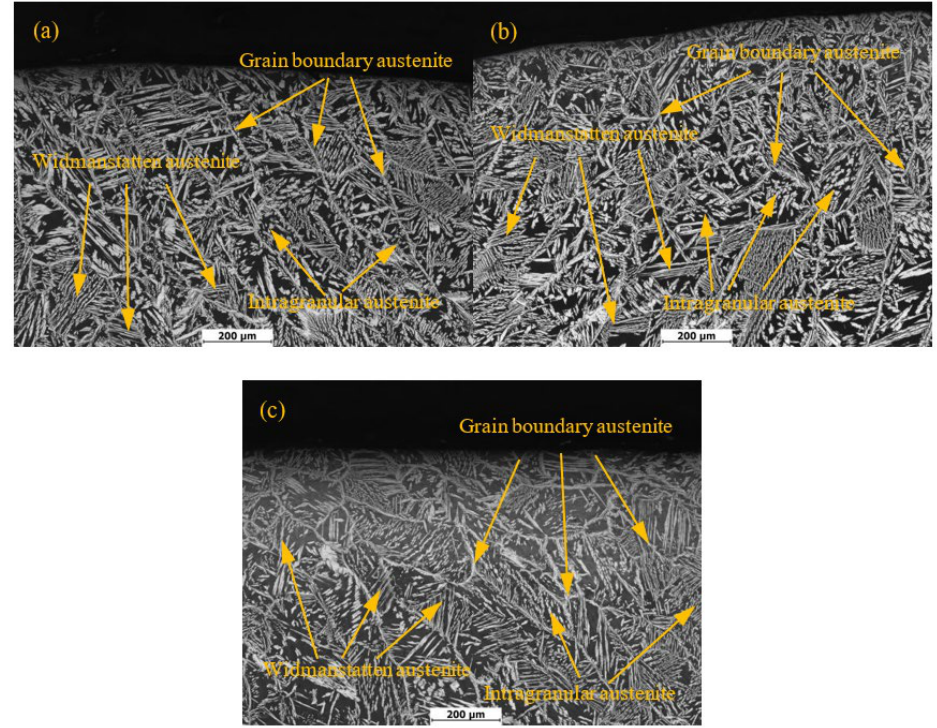
Figure 3. Microstructure of the DSS 2205 weld seam area with different treatment methods: ( a ) Untreated; ( b ) pneumatic chipping hammer; ( c ) ultrasonic impact peening.